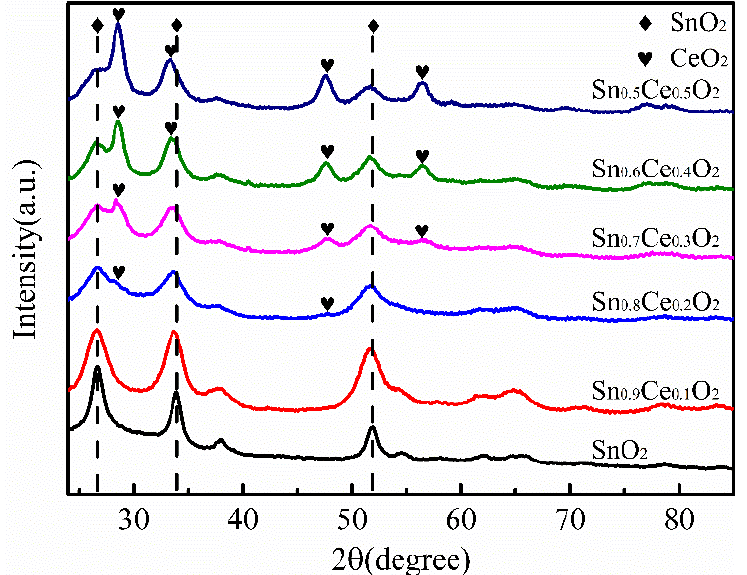
Figure 2. X-ray diffraction (XRD) patterns of the SnO 2 and Sn x Ce 1 − x O 2 fiber catalysts. In Figure 2, compared with pure SnO 2 , the diffraction peak of SnO 2 in the Sn x Ce 1 − x O 2 catalyst shifted to a lower angle, and the intensity of the diffraction peak weakened, indicating that Ce entered the crystal lattice of SnO 2 , destroyed the structural symmetry of the catalyst, and reduced the crystallinity. It can be observed from Table 1 that the lattice constant of the Sn x Ce 1 − x O 2 catalyst was larger than that of pure SnO 2 because the ionic radius of Ce (Ce 3+ : 0.103 nm; Ce 4+ : 0.092 nm) was larger than that of Sn (Sn 2+ : 0.093